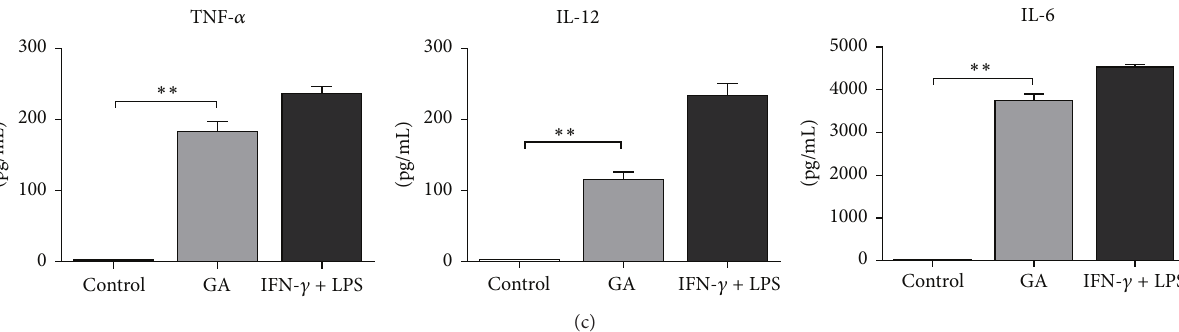
Figure 4: Effect of GA on M1- and M2-related markers expression in BMDMs. BMDMs were treated with GA (100 𝜇 g/mL) for 48h, the cells and supernatants were collected. (a) CCR7 and MR expressions were analyzed by FACS and (c) TNF- 𝛼 , IL-12, and IL-6 secretions were quantified by ELISA. (b) BMDMs were treated with GA (100 𝜇 g/mL) for 6 h, total RNA was extracted, and TNF- 𝛼 , IL-12 , IL-6 , Ym1 , MR, and FIZZ1 expressions were measured by real-time PCR. Data are expressed as mean ± SD from three independent experiments. ∗ 𝑃 < 0.05 , ∗∗ 𝑃 < 0.01 ( 𝑡 -test).